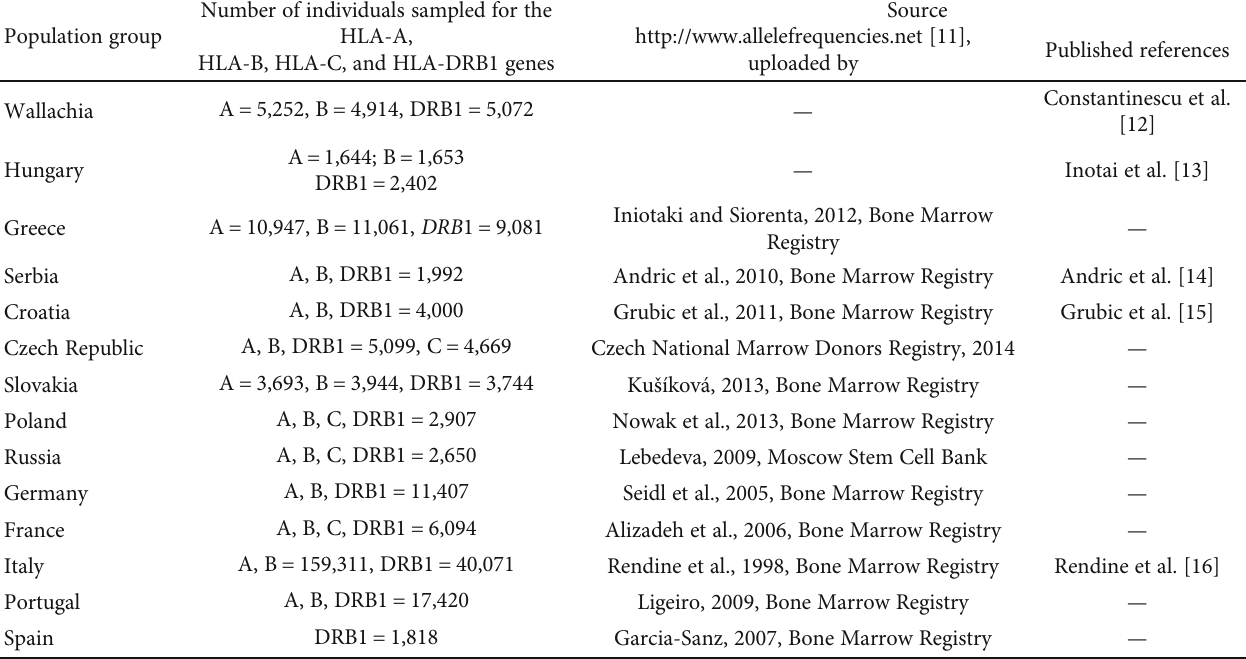
Table 1: Resources which provided the frequencies of the HLA-A, HLA-B, HLA-C, and HLA-DRB1 genes in several European population